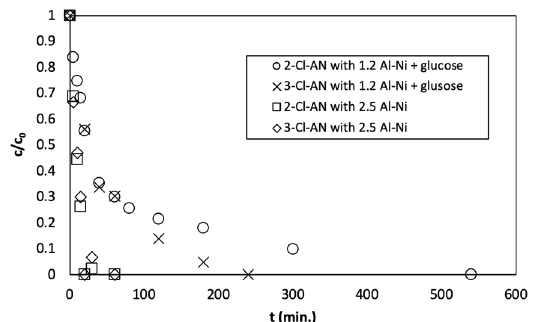
Figure 2. A comparison of the reaction rate of o - and m -chloroaniline (Cl-AN) by Al-Ni/NaOH with and without co-action of glucose (ratio of reactants: 2 mmol of studied Cl-AN, 0.13 g Al–Ni alloy, 10 mmol glucose, and 25 mmol NaOH in 200 mL water; stirring at 500 rpm and 25 °C, for more details see [23]).